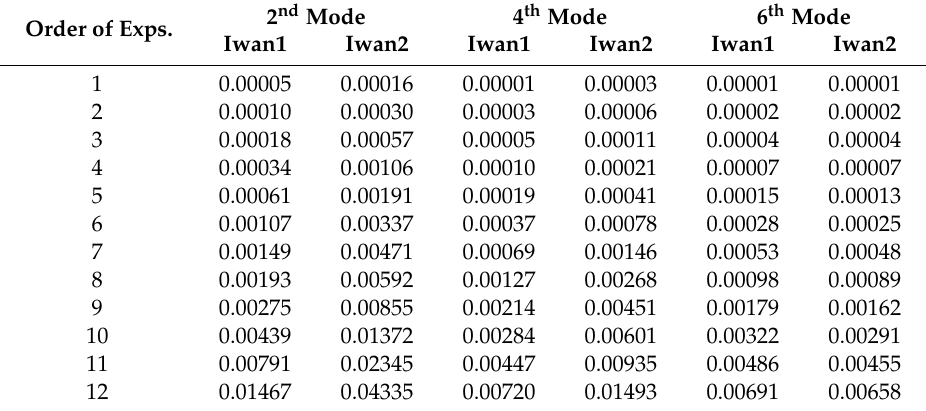
Table 1. List of the relative displacements in the Iwan models for the modes of interest. 2 nd Order of Exps.